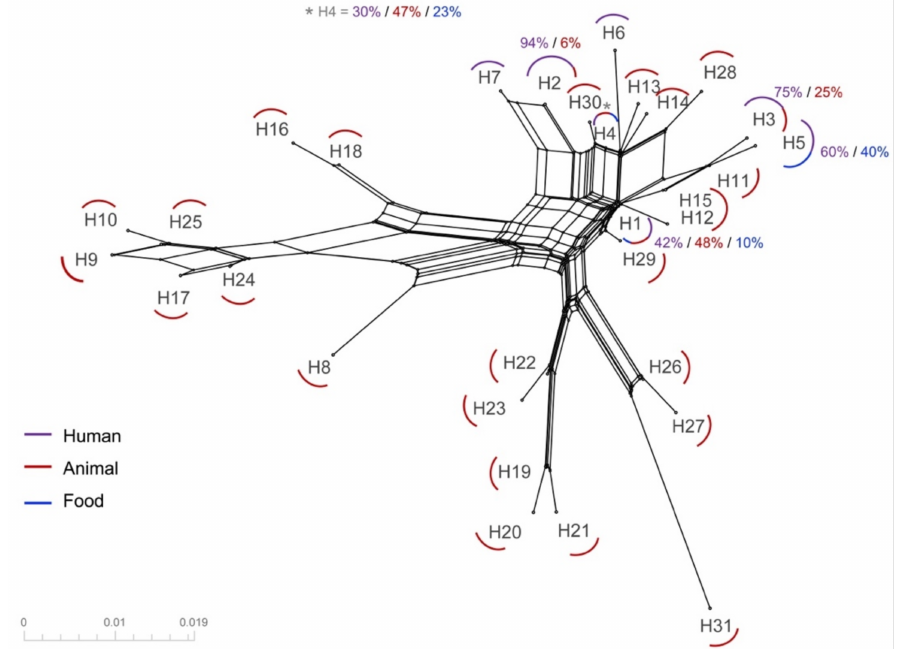
Figure 3. Phylogenetic network obtained from the alignment of representative haplotypes based on Neighbor-Net algorithm performed on SplitsTree. Reticulation events among haplotypes were identified, including both Colombian sequences and those from other regions. Colors represent sample source: Red—bovine, Blue—food, Purple—humans. Reticulation events between mixed sources were identified, particularly for Haps 1 and 4 at the central network hub, in which the three sources of the virus were